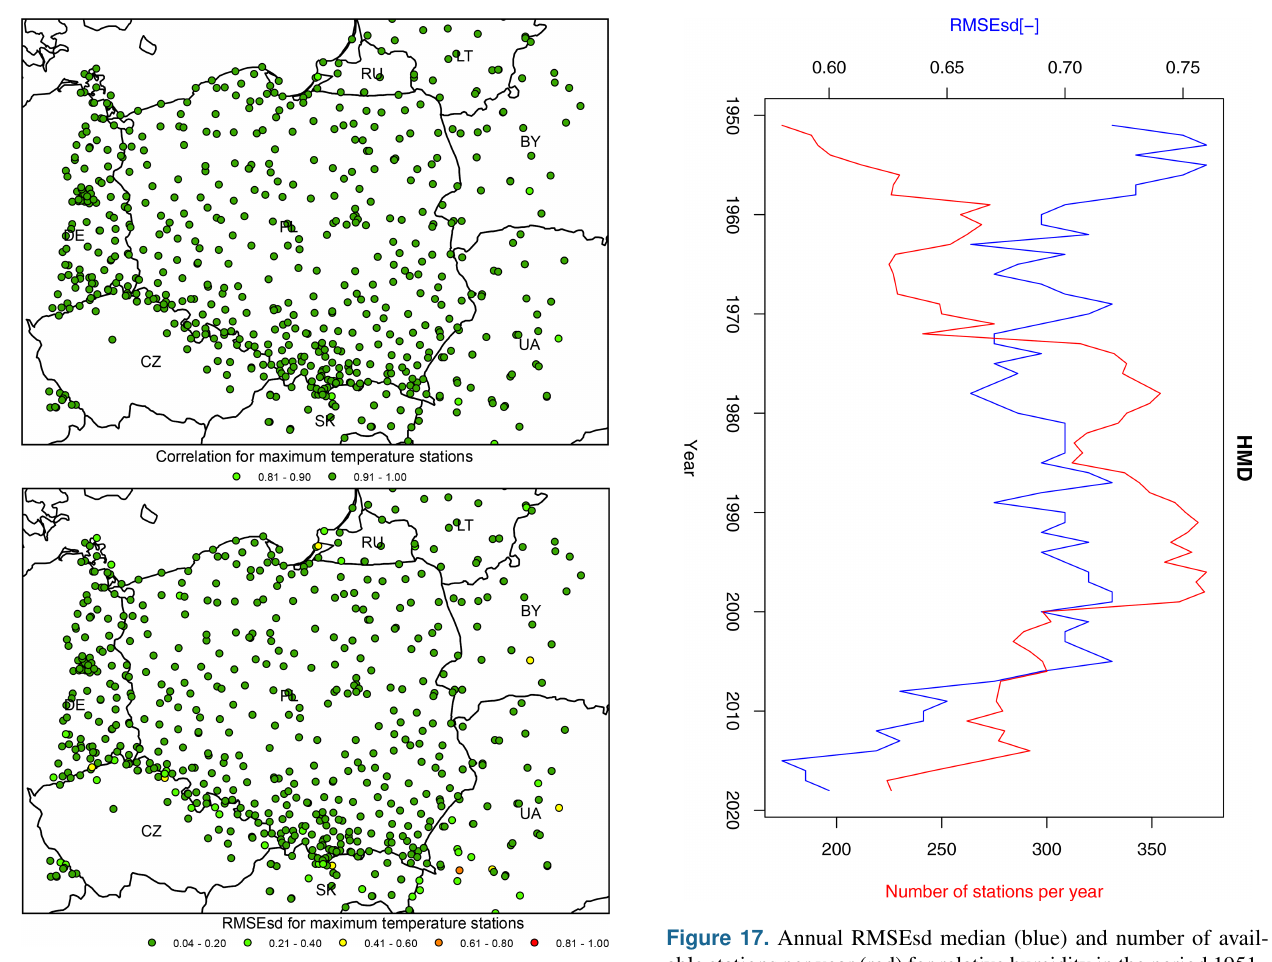
Figure 16. Maximum temperature ρ (top) and RMSEsd (bottom) values calculated for stations in the period 1951–2019. National borders (black lines) are labelled with country codes.